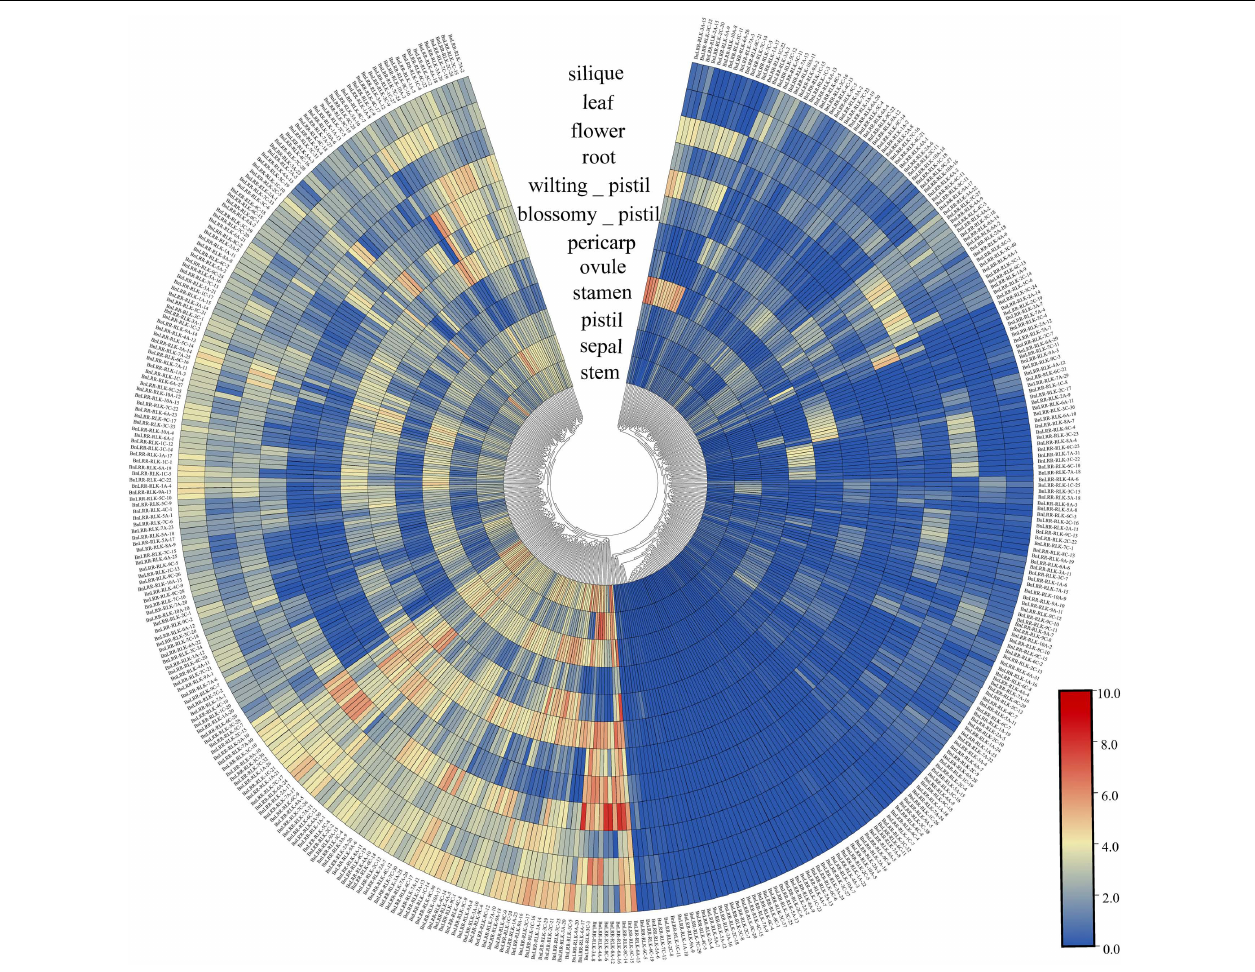
FIGURE 3 | Expression profiles of BnLRR-RLKs in different tissues. Publicly available RNA-seq data of root, stem, leaf, flower, silique, sepal, pistil, stamen, ovule, pericarp, blossomy pistil, and wilting pistil from ZS11 were download for expression profile analysis. The expression level is equal to the mean values and transforms log2 values for normalization. Colors from blue to red represent relative expression levels from low to